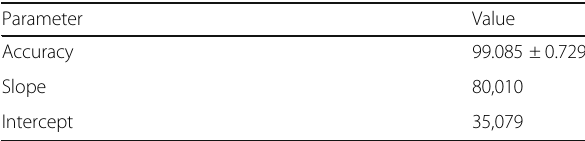
Table 3 Method precision results (% RSD) for 4 individual preparations of a sample for Chlorpyrifos Concentration ( μ